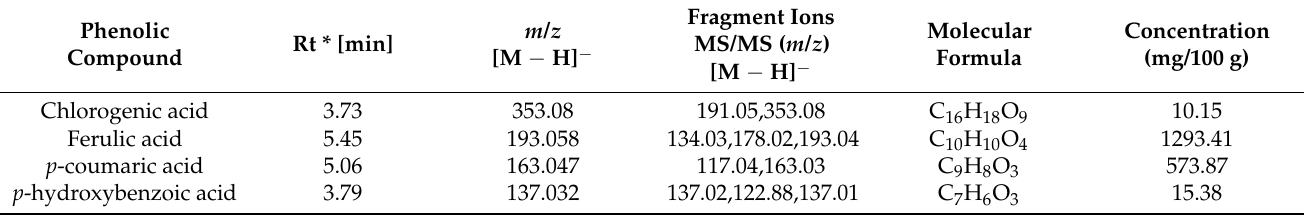
Table 1. Qualitative and quantitative characterization of phenolic compounds in corn husk by UPLC-ESI-Q-ToF-MS/MS. Phenolic